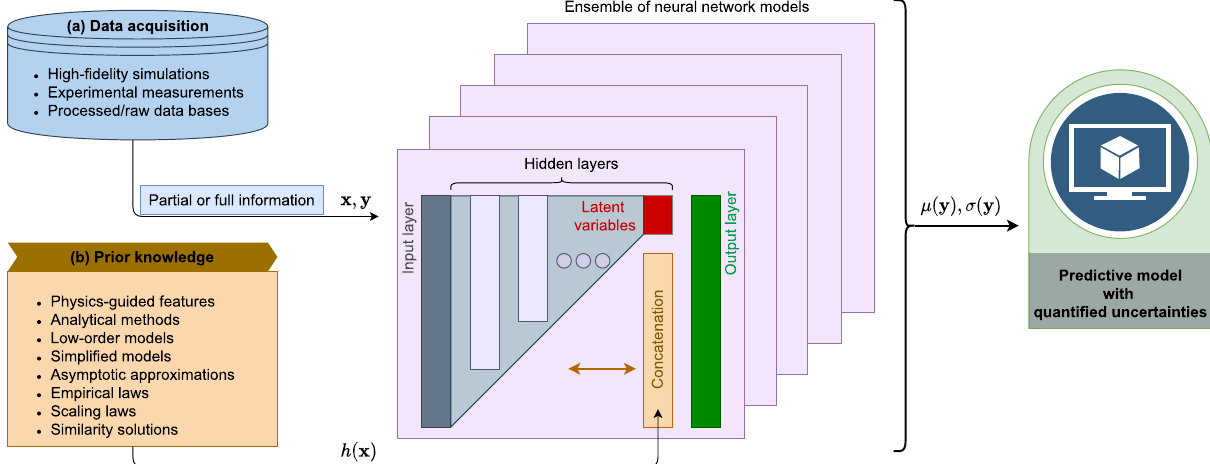
Figure 1. The proposed multi-fidelity information fusion framework. The prediction from the low-fidelity models (e.g., self-similarity solution or law of the wall) is concatenated with the latent variables at the certain hidden layer of the neural network. An ensemble of neural networks is trained using the negative log-likelihood loss function to estimate the uncertainty associated with the prediction. Here, x refers to independent variables or design parameters, or y indicates the quantities of interest, and h ( x ) represents a low-fidelity or simplified model that is